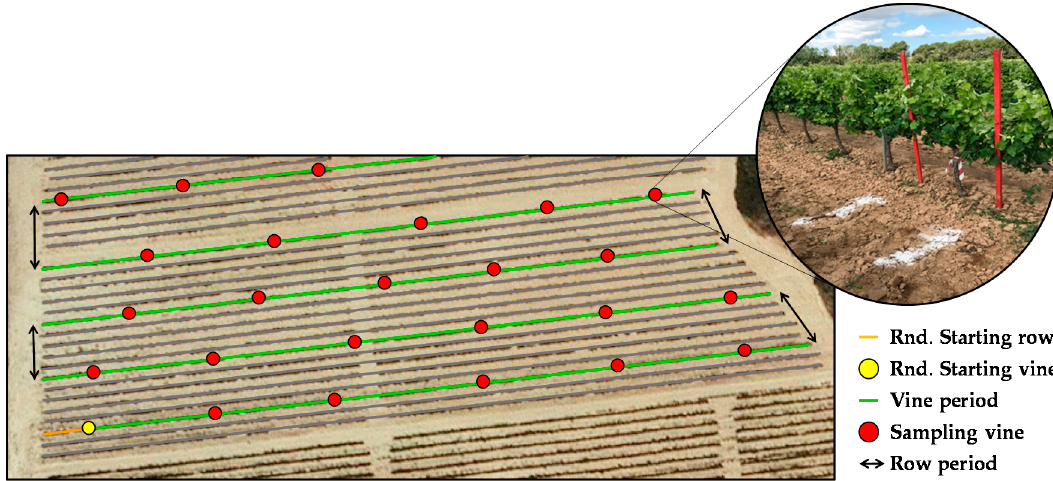
Figure 2. Scheme of SUR sampling used in plot A in 2018. Identification system for sampling vines in field.